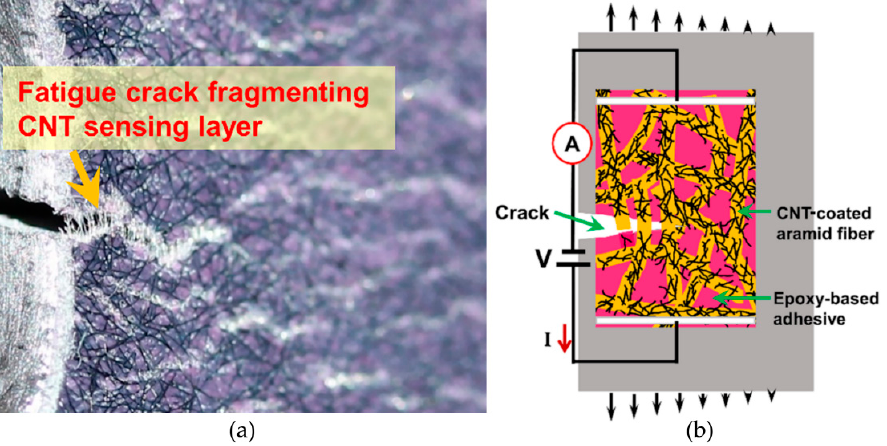
Figure 1. Illustration of carbon nanotube (CNT)-based fatigue sensor concept: ( a ) photo of crack fracturing the sensor and ( b ) sensing principle using electrical resistance measurements across applied electrodes (white lines).